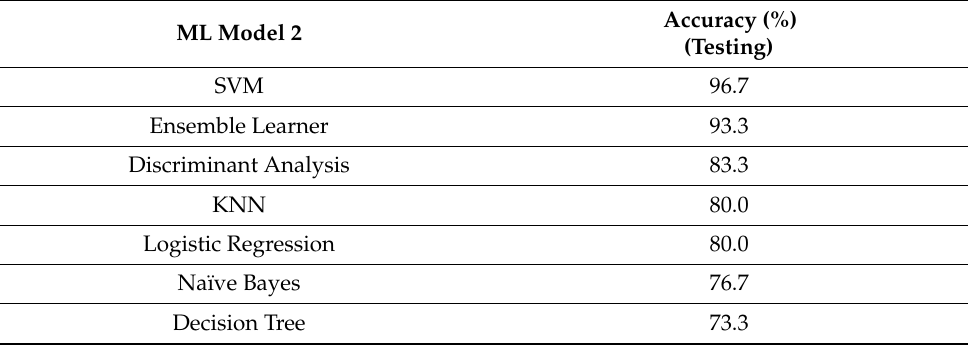
Table 9. Results of the stumble-type classification problem